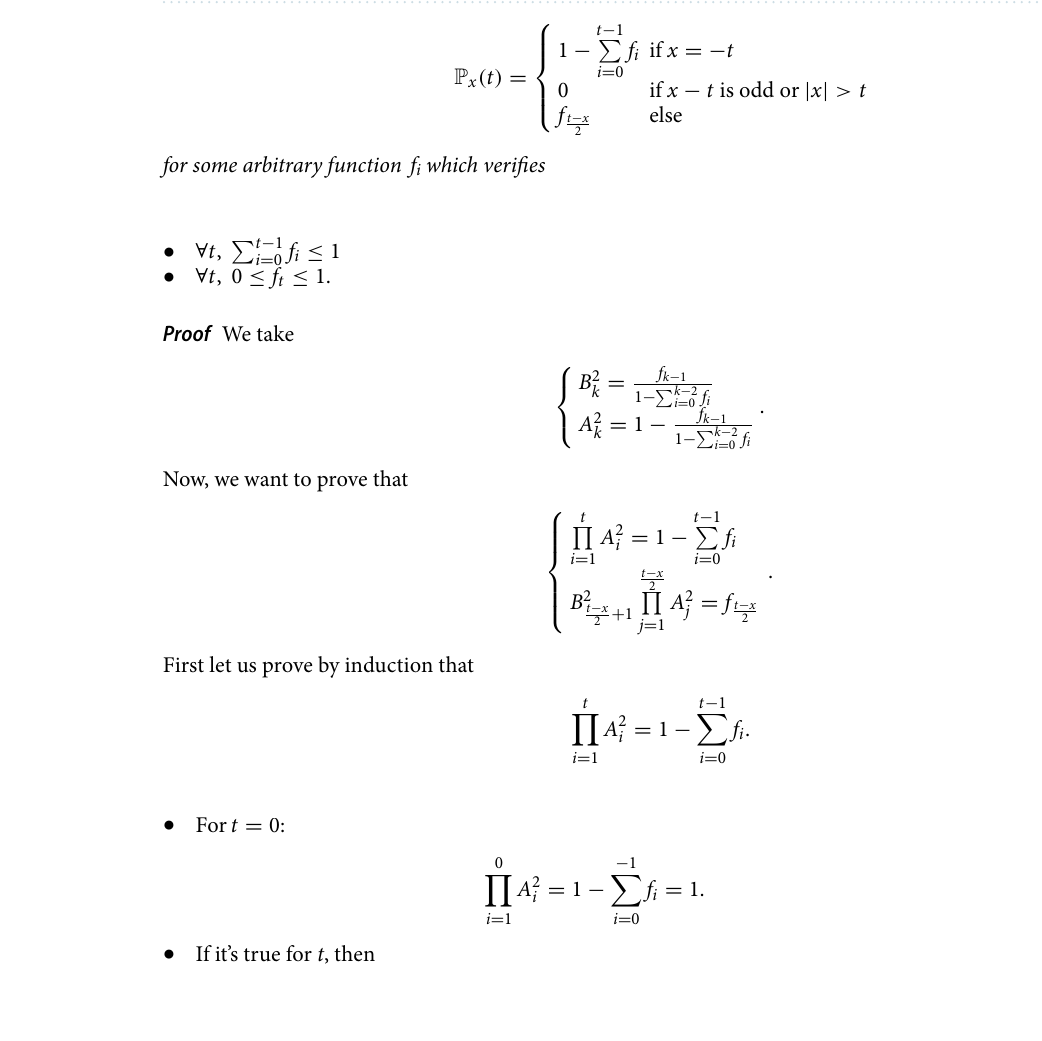
Figure 4. Mean trajectory of the walker for different values of z . (Bottom) Variance of the walker for different values of z . Points represents the theoretical prediction, the dashed line coincides with the numerical